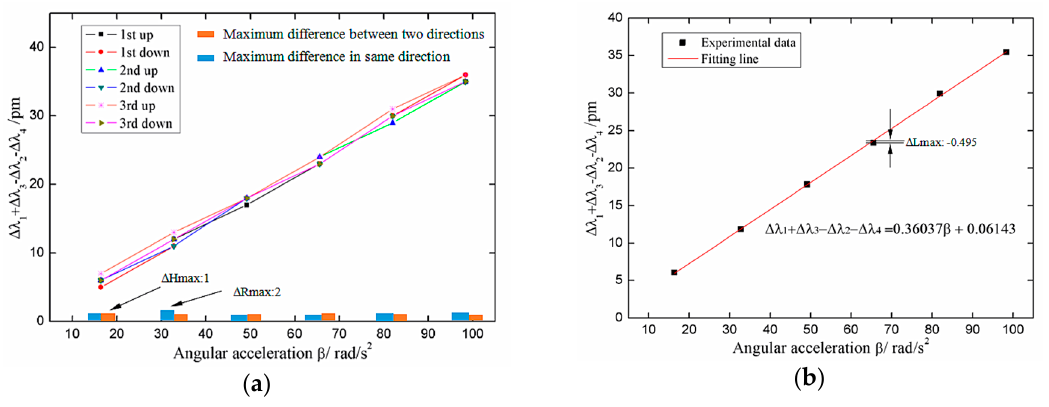
Figure 12. The relationship between ∆ λ 1 + ∆ λ 3 − ∆ λ 2 − ∆ λ 4 and angle acceleration. ( a ) The plot and ( b ) the linear fitted curve of ∆ λ 1 + ∆ λ 3 − ∆ λ 2 − ∆ λ 4 versus vibration angle